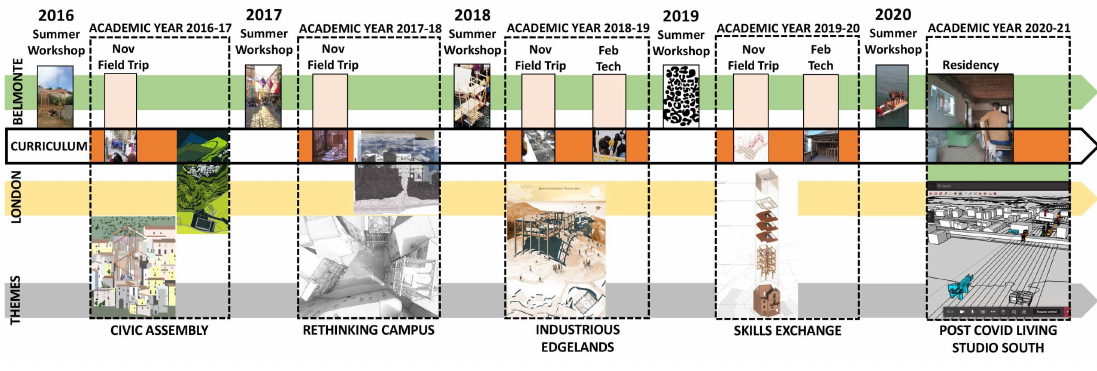
During the first three years of the onsite activities, the work focused on small-scale, mobile constructions. Benches, chairs, shelving towers (used for exhibitions and to fix projectors at events) and canopies (covering large tables for community dinners) were made jointly with locals and asylum seekers (Figure